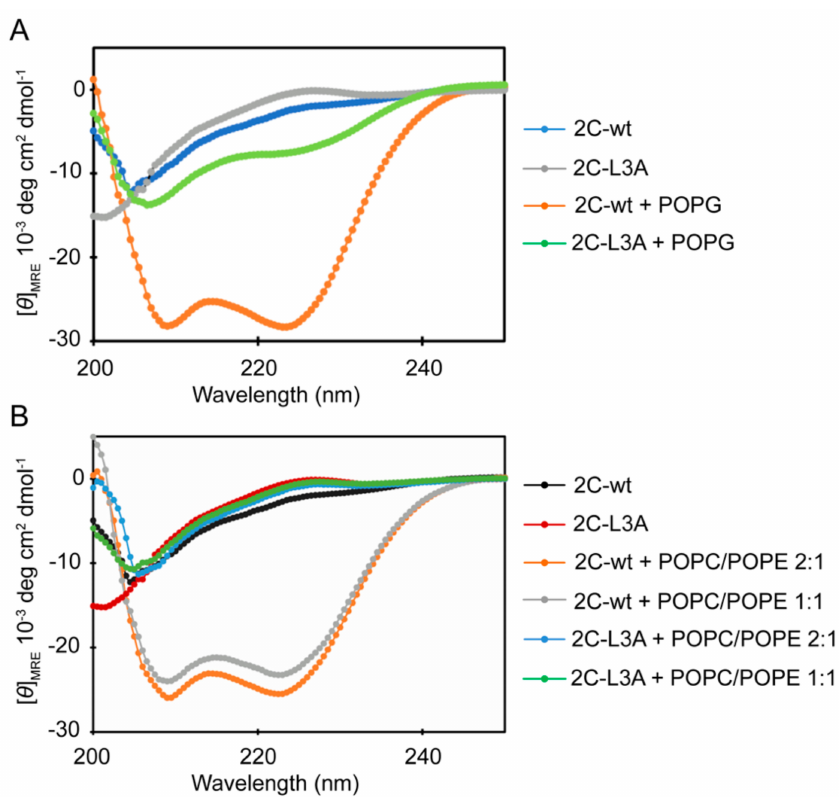
Figure 3. Circular dichroism spectra of 2C-wt and 2C-L3A with and without liposomes. ( A ) CD spectrum of 2C-wt and 2C-L3A in the presence of negatively charged POPG vesicles; 2C-L3A has drastically reduced helicity compared to 2C-wt. ( B ) CD spectrum of 2C-wt and 2C-L3A in the presence of a different ratio of POPC / POPE; 2C-L3A displays reduced helicity compared to 2C-wt. The peptide concentration was 100 µ M and the lipid concentration was 500 µ M.